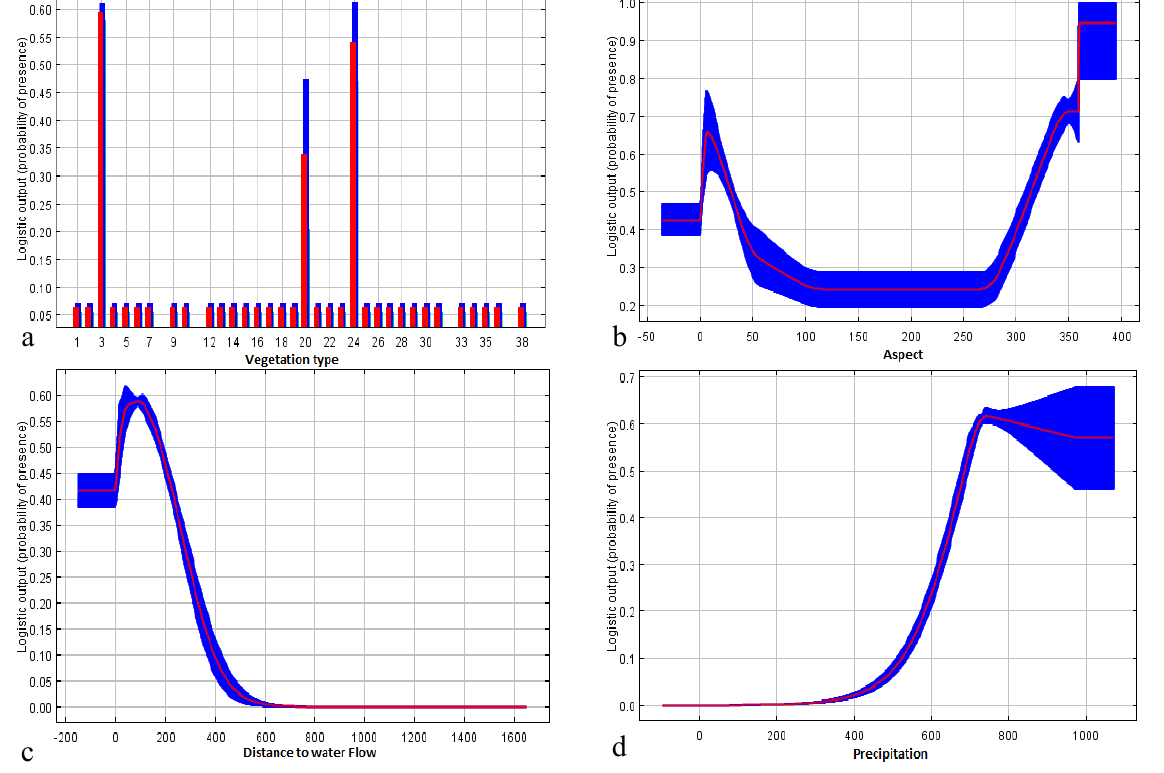
Figure 8. Response curves of the variables that most contributed to explain the potential distribution of Picea chihuahuana Martínez in Mexico ( a = Vegetation type, b = Aspect, c = Distance to water flows, d = Annual precipitation): model at local